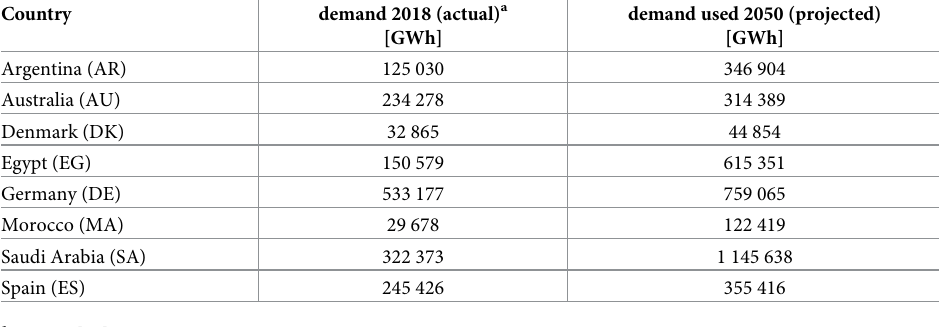
Table 4. Used future (2050, projected) electricity demand and actual (2018) for